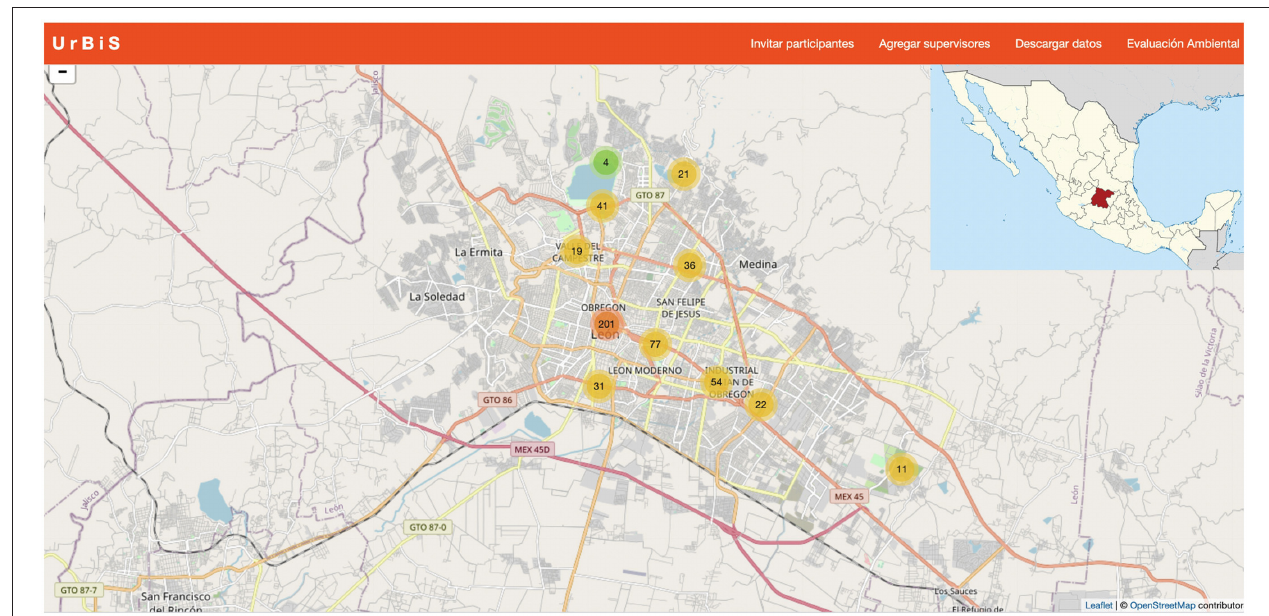
FIGURE 3 | The UrBis platform map showing the points in which psychological and sensory data were collected in Leon,